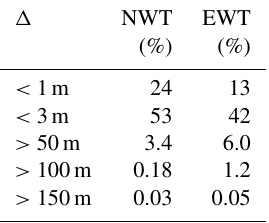
Table 2. Absolute differences between ground-observed and mod- elled water table depths ( (cid:49) ) and their percentage of occurrence in the Canterbury region for the NWT and EWT